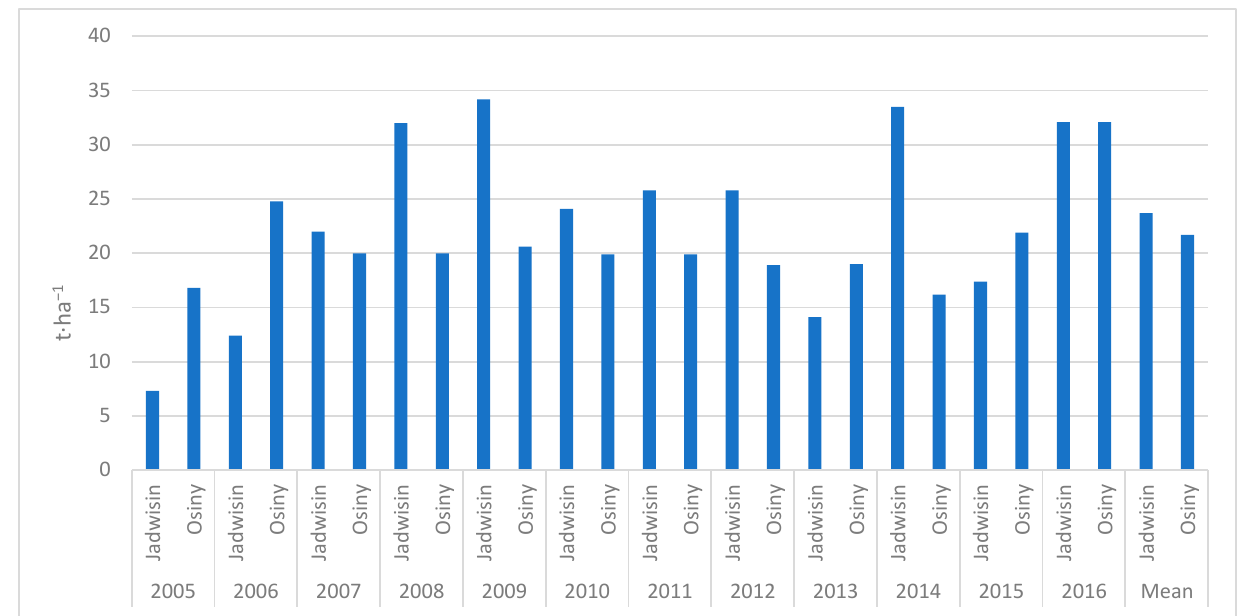
Figure 2. Tuber yield depending on site and years of growing (mean for 30 varieties).